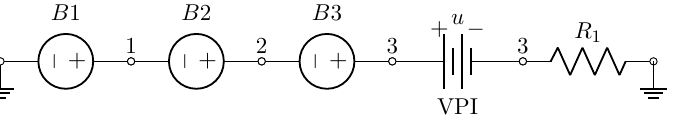
Figure 12. Circuits to generate the values of y(t) and y’(t) What is the homogeneous differential equation that verifies the APB curve. Rewriting the (22) in the following way, xdx + ydy = ± p x 2 + y 2